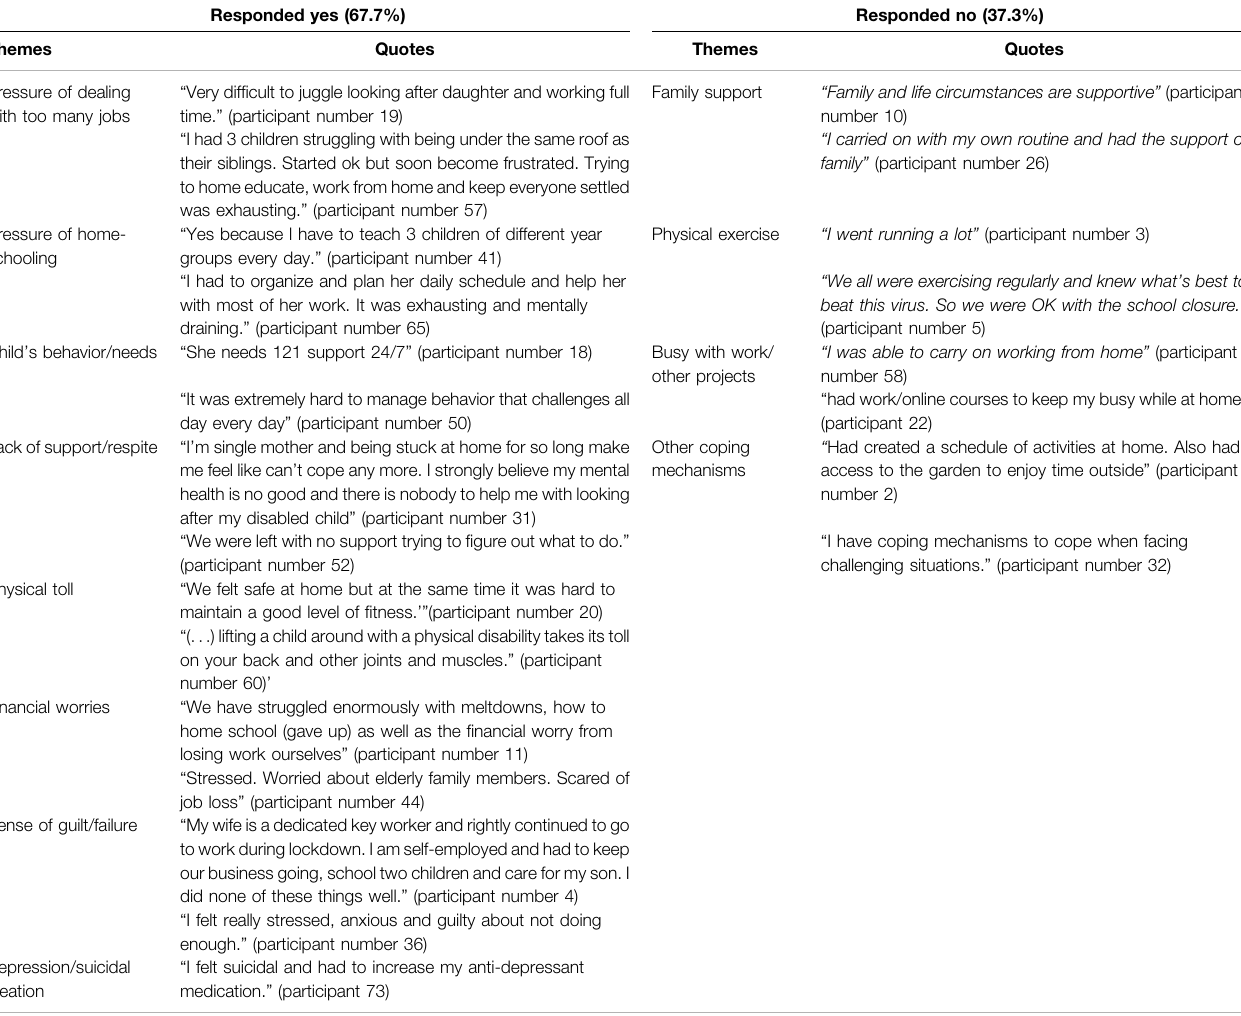
TABLE 4 | Themes and quotes resulting from the analysis of responses to the items “ Do you think that school closures had a detrimental effect on YOUR physical and/or mental health? ” and “ please tell us why ” . Responded yes (67.7%)